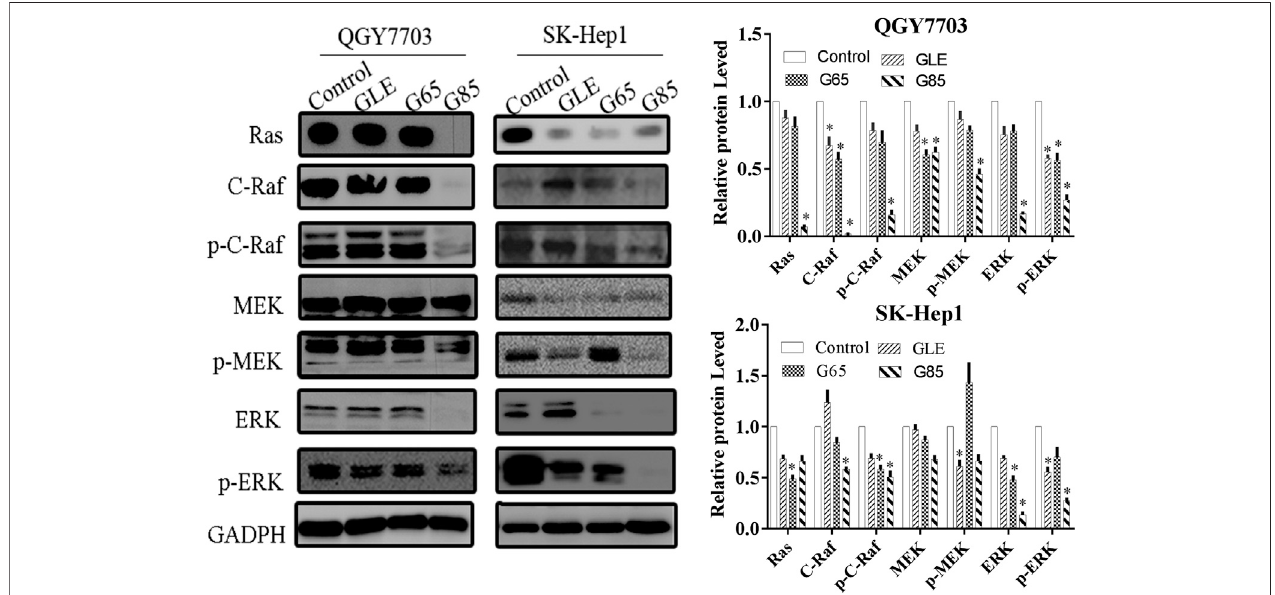
FIGURE 6 | G. lucidum extracts signi fi cantly inhibited Ras/Raf/MEK/ERK signaling pathway. QGY7703 and SK-Hep1 cells were treated with GLE, G65, and G85 (150 μ g/ml) for 48 h. The expressions of Ras, c-Raf, p-c-Raf, MEK, p -MEK, ERK, and p -ERK were determined by western blotting. The western blot density was analyzed, and the values of each protein were normalized with the values of the internal reference protein GADPH, and further compared with the control group. Data were shown as mean ± SD. * p < 0.05, vs control.